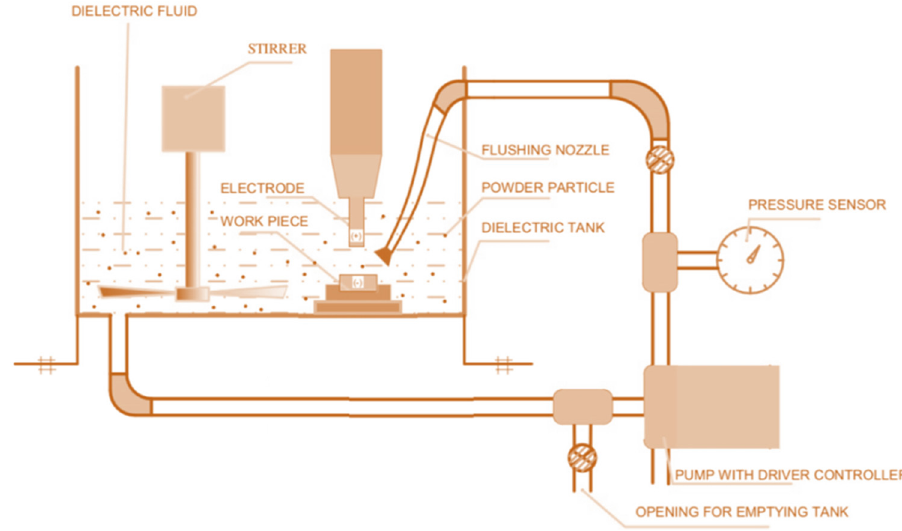
Figure 1: Experimental scheme used in the present